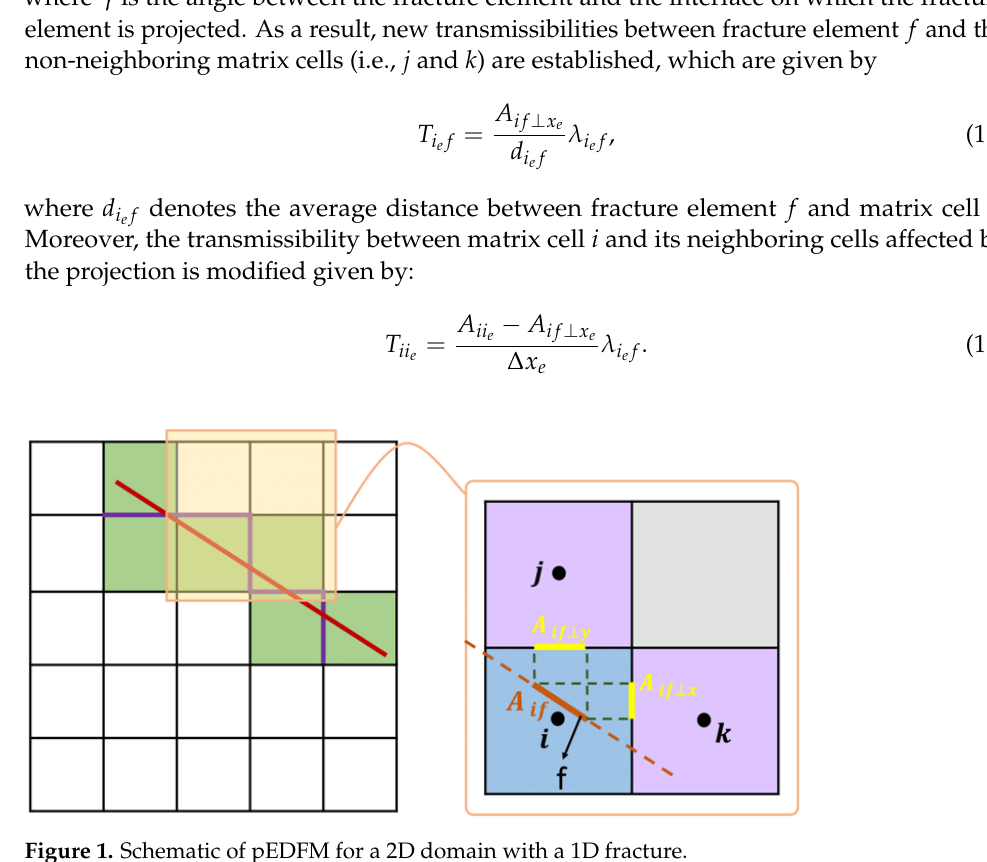
Figure 1. Schematic of pEDFM for a 2D domain with a 1D fracture.